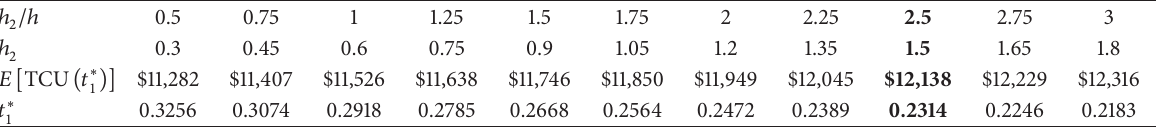
Table 3: Variations of the unit retailer’s holding cost ℎ 2 and their effects on 𝐸[ TCU (𝑡 ∗ 1 )] .